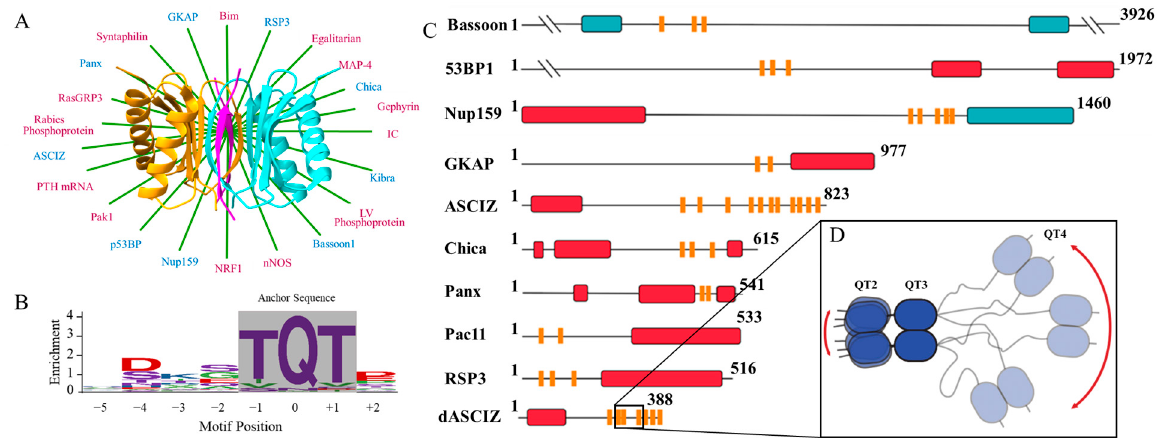
Figure 1. LC8 hub, binding motif, and multivalent partners. ( A ) Ribbon diagram of the LC8 dimer showing each monomer (orange and cyan) bound to disordered peptides (magenta) that adopt β -strand structure upon binding in LC8’s binding groove (Protein Data Bank code 2P2T, from D. melanogaster ). Ribbon diagram is overlayed on a star display of a selection of LC8 partner proteins. Red font denotes monovalent partners, while blue denotes multivalent partners. ( B ) Amino acid enrichment for each position in the LC8 binding motif. The TQT anchor is boxed in gray. ( C ) Multivalent LC8 binding partners. Sequence-based predictions of order (red boxes), disorder (black lines), coiled-coil (blue boxes), and LC8 binding motifs (orange bars) are shown. PSIPRED [16] was used to predict order and disorder. Paracoil2 [17] was used to predict coiled-coils. LC8 binding motif locations are shown for Bassoon [18], 53BP1 [19], NUP159 [20], GKAP [21], ASCIZ